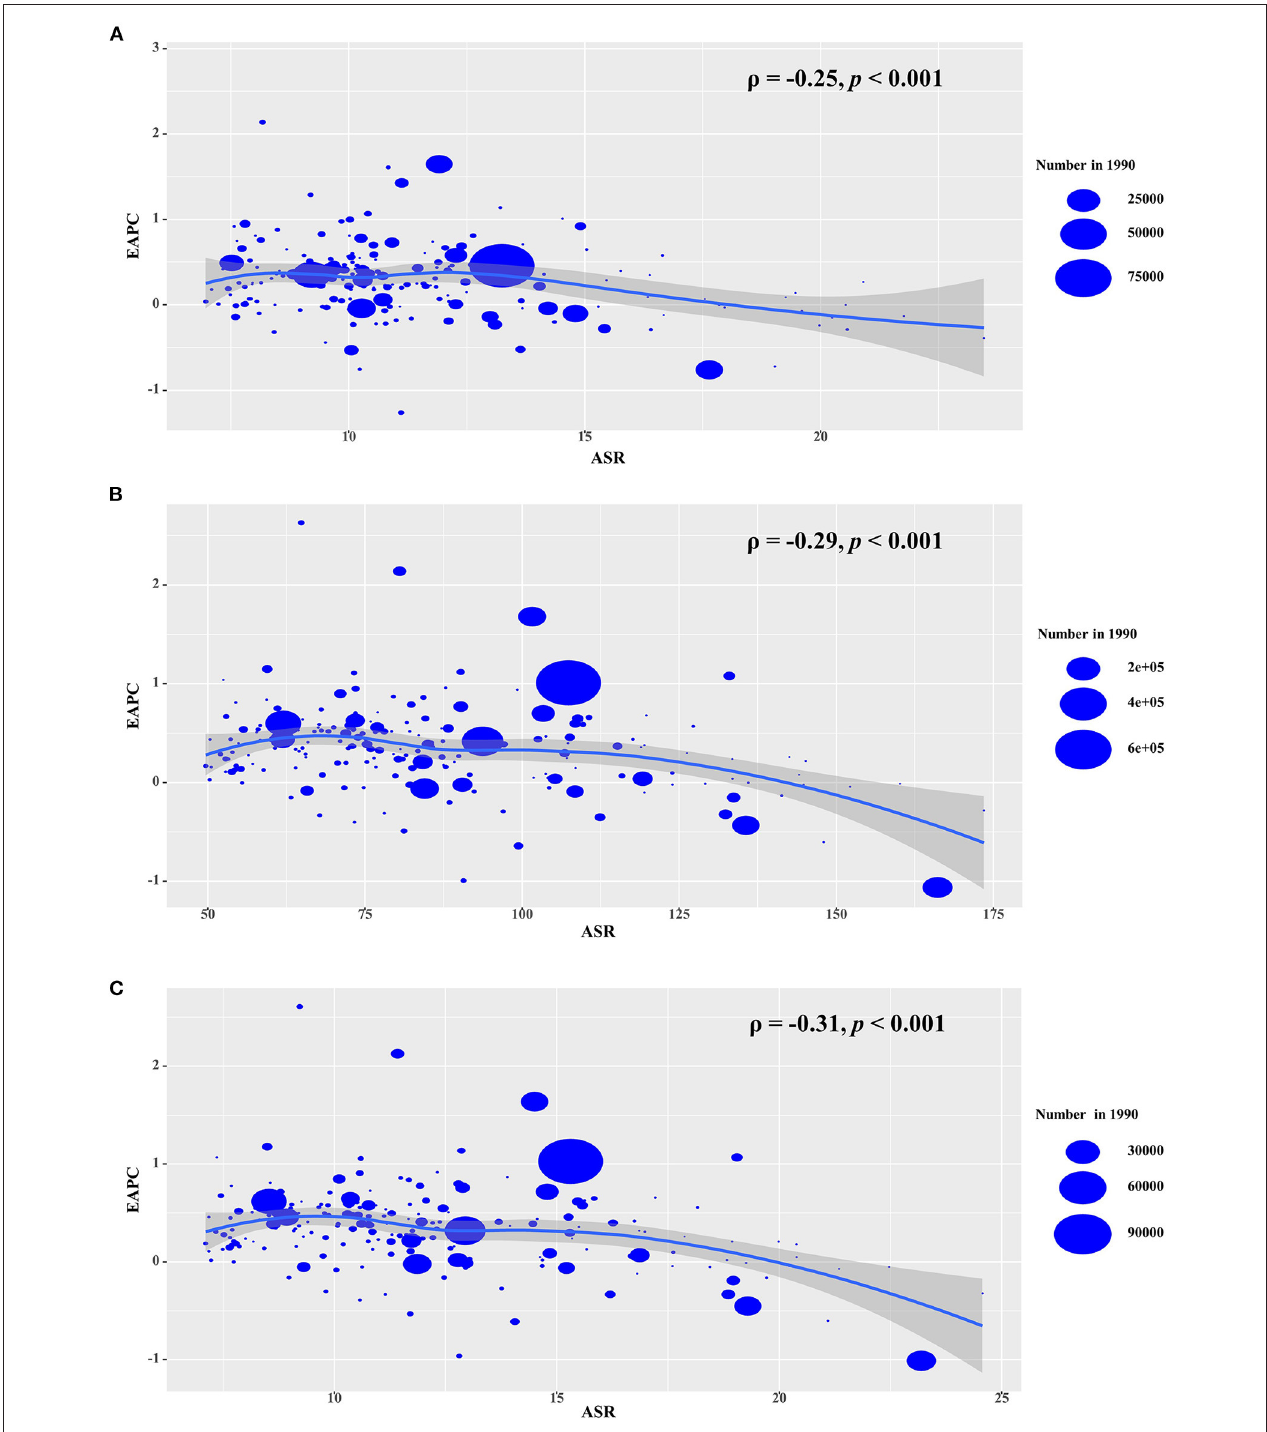
FIGURE 7 | The association s between EAPCs and ASRs in 1990 at the national level. EAPCs of incidence (A) , prevalence (B) , YLDs (C) had negative associations with ASR in 1990, respectively. The association was calculated with Pearson correlation analysis. The size of circle is increased with the numbers in 1990. EAPC, estimated annual percentage change; ASR, age-standardized rate; YLDs, years lived with disability.